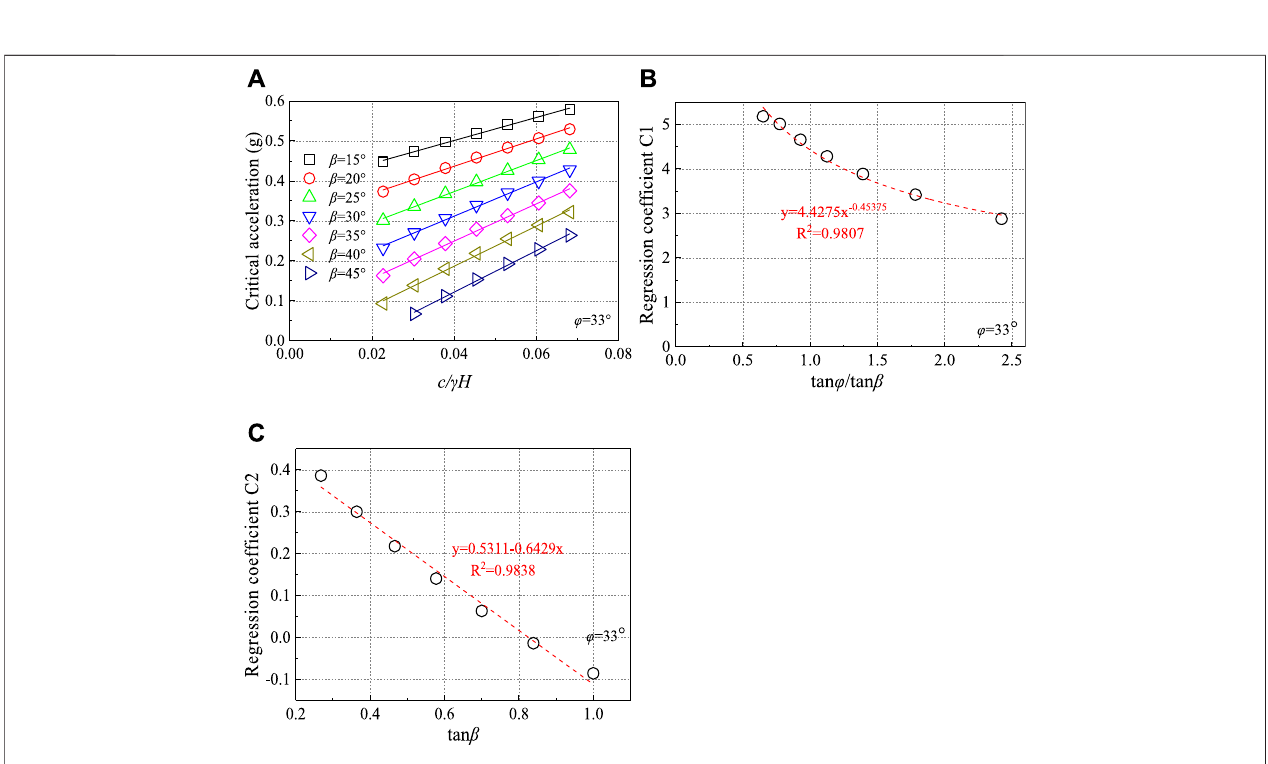
FIGURE 3 | Example of (A) A c versus c/ γ H and (B) coef fi cient C1 (MC) and (C) coef fi cient C2 (MC) when friction angle is 33 ° .